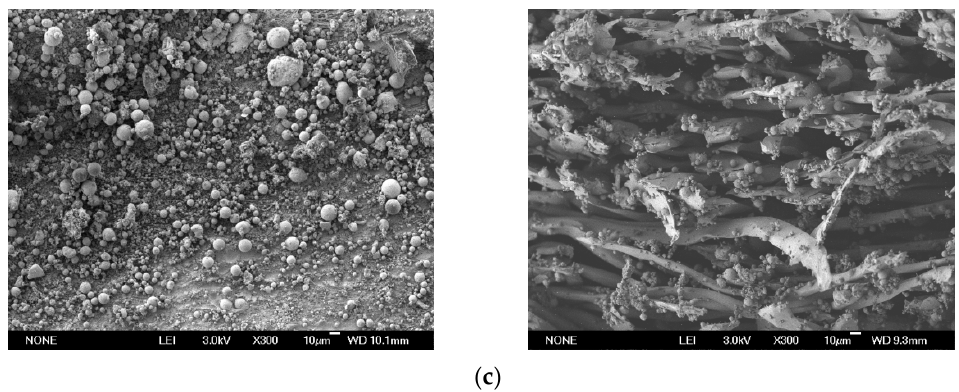
Figure 6. SEM micrographs of three types of filter bags after the experiment: ( a ) filter bag 1; ( b ) filter bag 2; ( c ) filter bag 3.